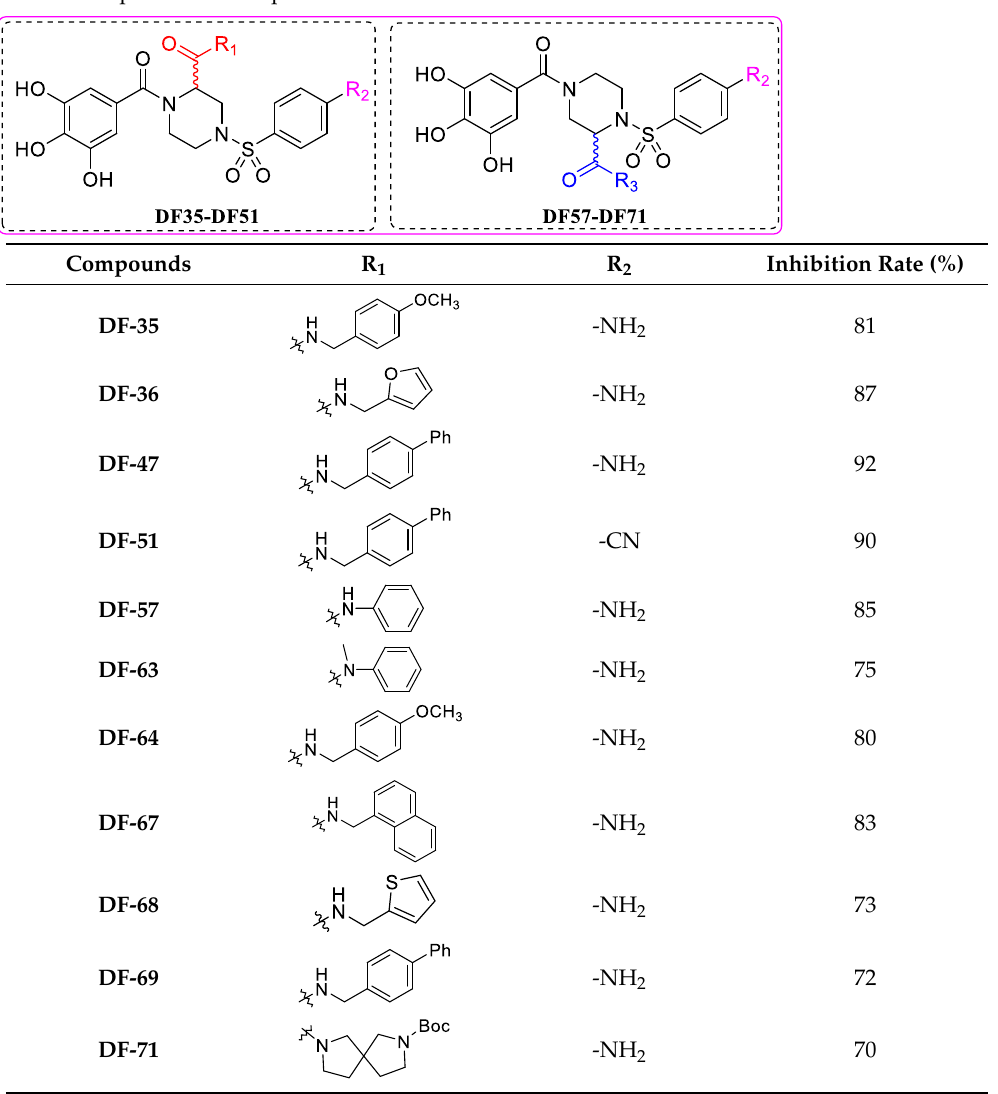
Figure 3. Inhibition of RNA-dependent RNA polymerase activity of 11 compounds. ( a ) Graphic representation of the 5′-6 FAM-labeled hairpin RNA substrate as primer-template used to monitor the inhibition of SARS-CoV-2 RdRp activity. +1 and +11, the positions of the first and the last nucleotide incorporated, respectively. ( b ) Gel picture with auto-contrast. Compound concentration: 1. 20; 2. 10; 3. 5 µM; (-): reaction in the absence of rNTPs; (+): reaction in the absence of com- pound. P: FAM-labeled RNA primer; FL: full-length RNA product. The data shown are from one representative experi- ment. ( c ) Gel picture with adjusted contrast. ( d ) Gel pictures of DF-47 and DF-51 . The concentrations of the compounds used are as follows: 1. 100; 2. 40; 3. 16; 4. 6.4; 5. 2.6; 6. 1; 7. 0.4 µM. ( e ) Dose–response curves of DF-47 and DF-51 . 2.2. Evaluation of Virus Inhibition Activity For the selected compounds listed above, we further evaluated their enzymatic inhi- bition potency under three concentration gradients (5, 10, and 20 μM), and the density of visualized stripes represent concentrations of RNA template and product in each well. At a concentration of 20 µM, most of the compounds still exhibited significant inhibition of RdRp activity. At 10 μM, DF-36 , DF-47 , DF-51 , and Baicalein remained partially active, whereas at 5 µM, only limited activity was observed (Figure 3c). To obtain accurate IC 50 values for DF-47 and DF-51 , both compounds were again tested under seven concentra- tions ranging from 0.4 to 100 μM (Figure 3d) to depict full dose–response curves. DF-47 turned out to be the most potent SARS-CoV-2 RdRp inhibitor with an IC 50 of 9.2 ± 1.1 μM. Unlike RDV-TP which causes delayed chain-termination during RNA synthesis via incor- poration of the nucleotide analog by the RdRp [39,40], these polyphenols are most likely to act by chelating with the magnesium ions of active center, thus directly blocking SARS- CoV-2 RdRp function. To further exploit pan-RNA virus inhibition of the compounds in Table 1, the com- pounds were evaluated as potential inhibitors of the RdRp domain of DENV NS5. We used a fluorescent-based assay to screen the compounds from Table 1 as potential DENV RdRp inhibitors. Only DF-47 and DF-51 were endowed with detectable inhibition to- wards DENV RdRp (Table 2). DF-51 displayed a low-micromolar IC 50 value of 4.8 ± 0.7